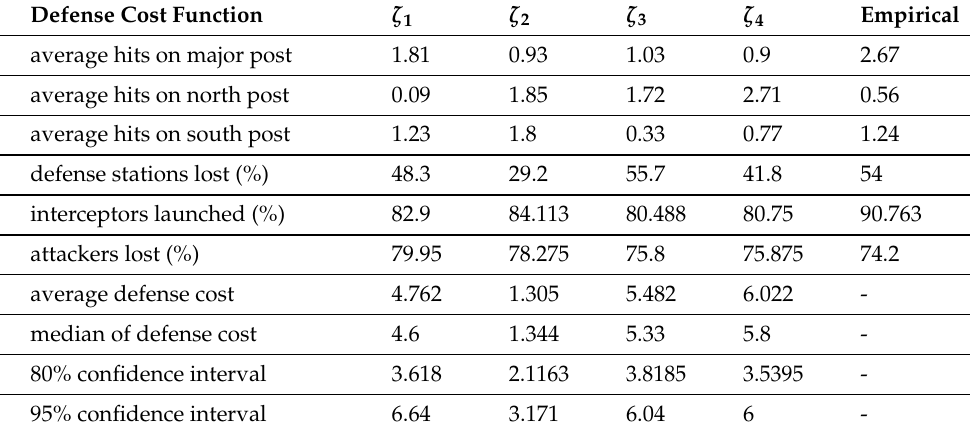
Table 5. Statistics of loss against pincer attack